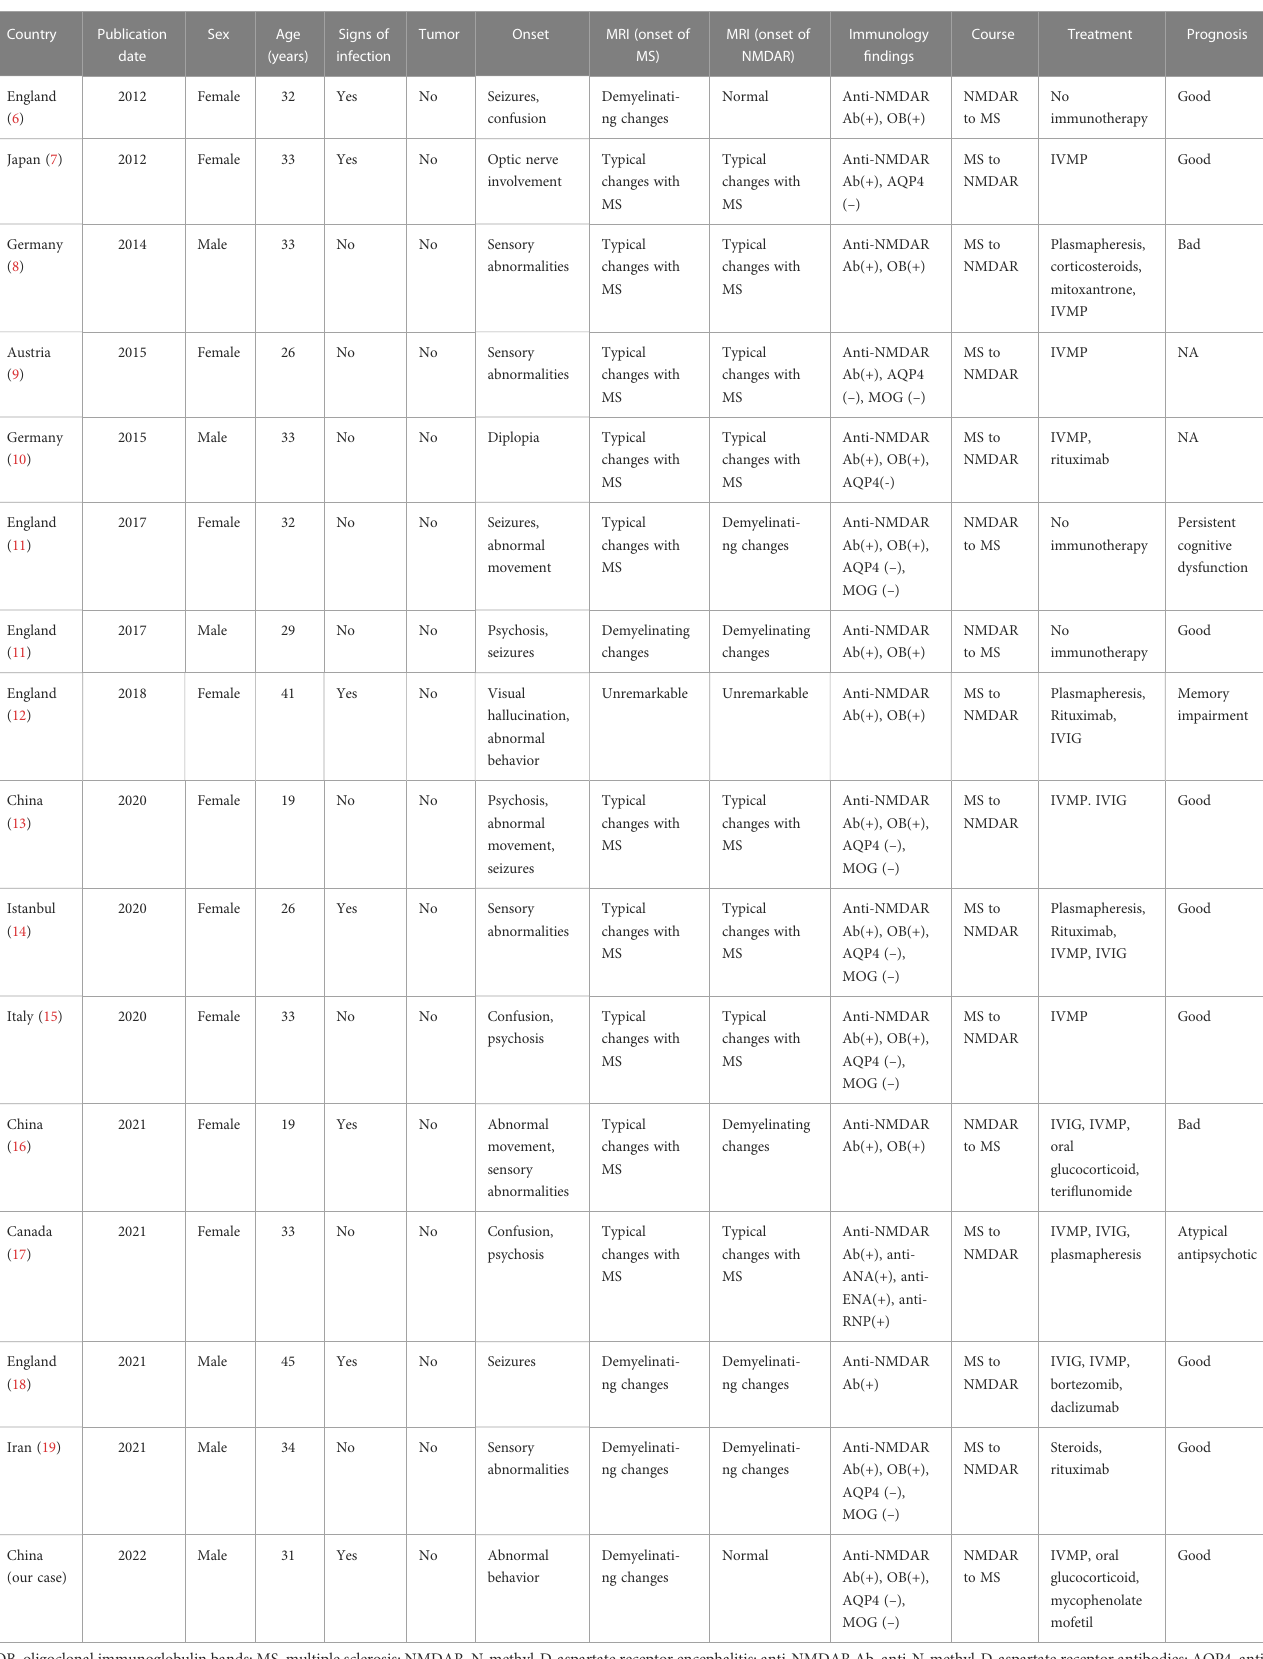
TABLE 1 Characteristics of patients with overlapping anti-NMDAR encephalitis and MS. Country